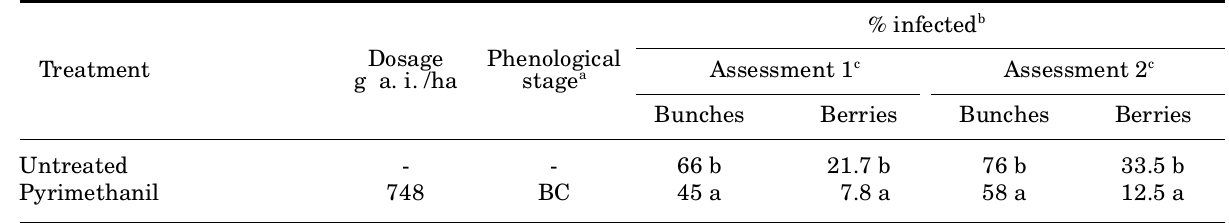
Table 11. Trial 4. Efficacy of different fungicides against Botrytis cinerea on grapevine, cv. Moscato, Saglietti Farm, Valdivilla,